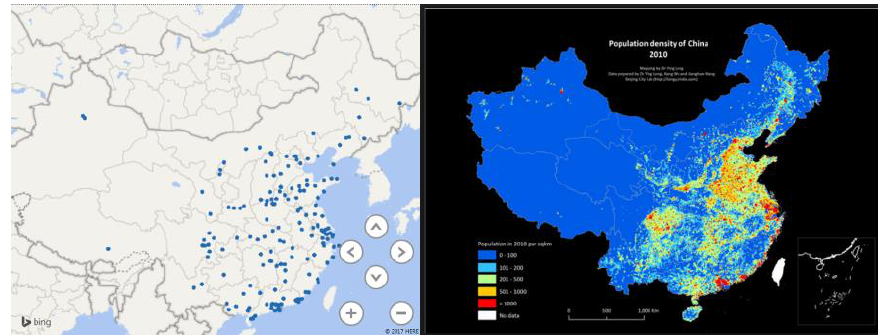
Figure 4. Depicts the locations of the sample participants who live in in China (left) and the population density of China in 2010 (right) [86]. Note: Each solid blue point represents the location of one respondent. From the perspective of geography, our samples are distributed randomly across the provinces of China.